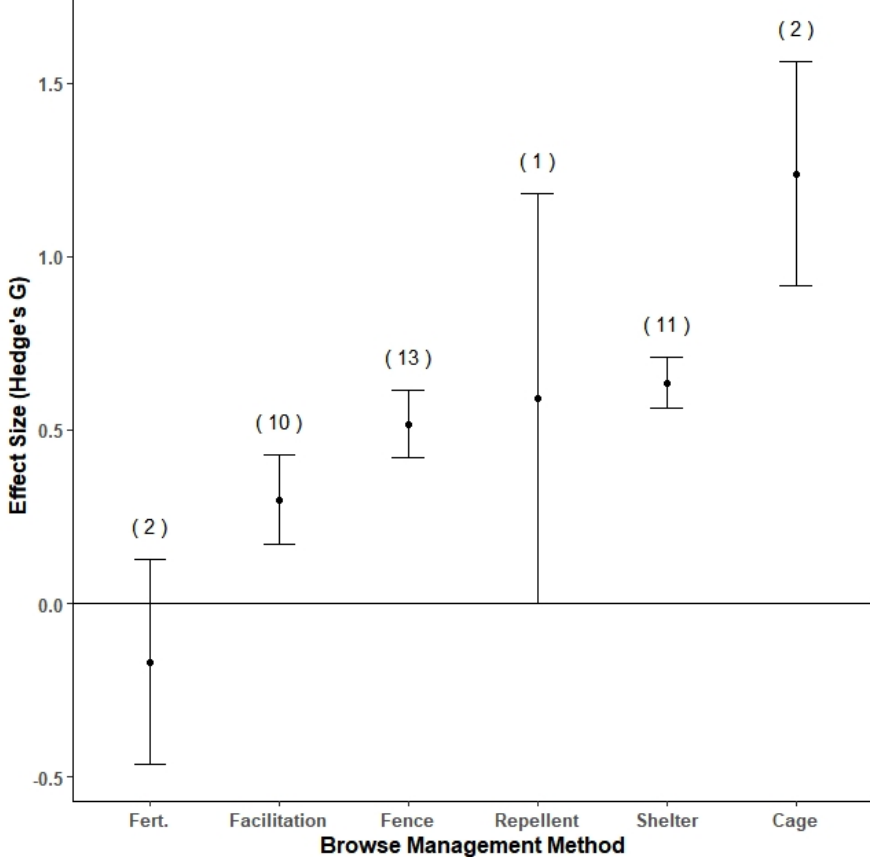
Figure 4. Mean and 95% confidence limits of height growth effect size (Hedge’s G) among six categories of browse management. Numbers in parentheses represent the number of individual studies used for each method.